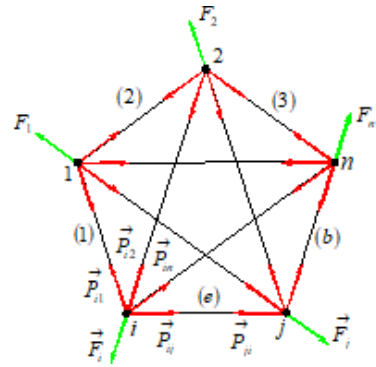
Figure 1: A system of central forces